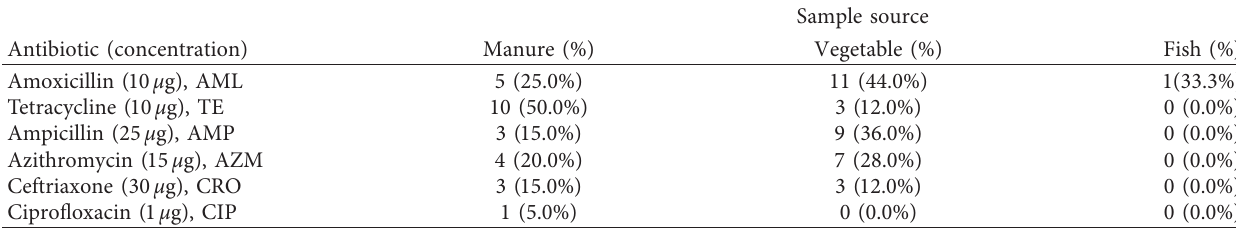
Table 2: Proportions of antimicrobial resistant E. coli isolates from different sources.